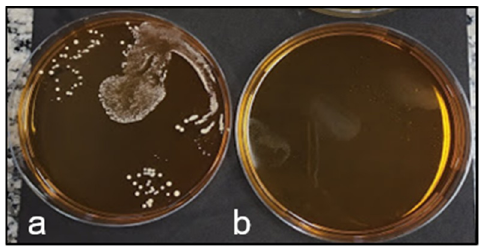
Figure 4. MRS media in petri dishes inoculated with wort before ( a ) and after ( b ) ionizing radiation treatment (20 kGy) in Study 2 (10 times dilution).